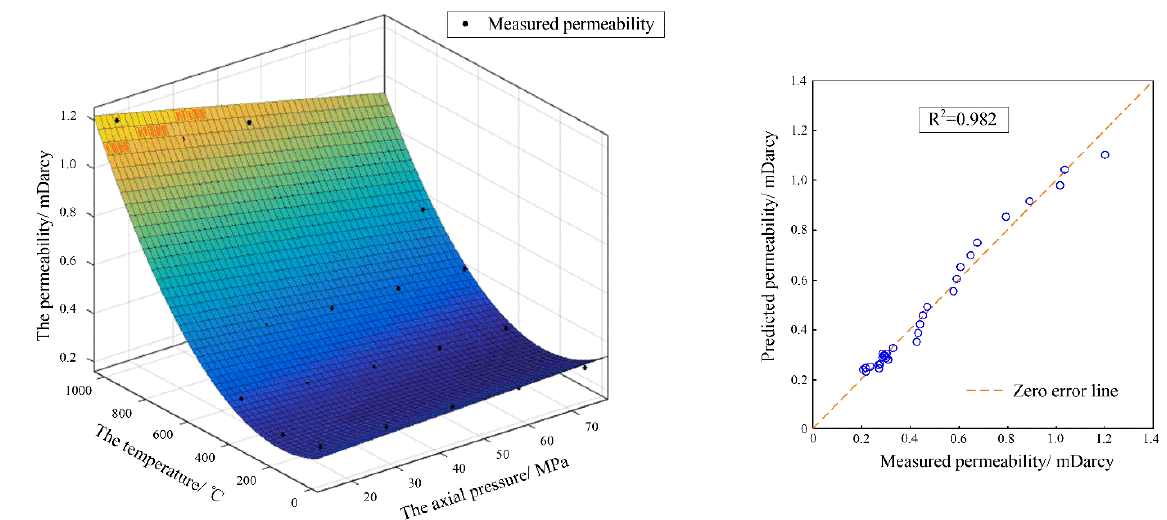
Figure 8. Fitting surface of sandstone permeability under temperature-stress coupling.